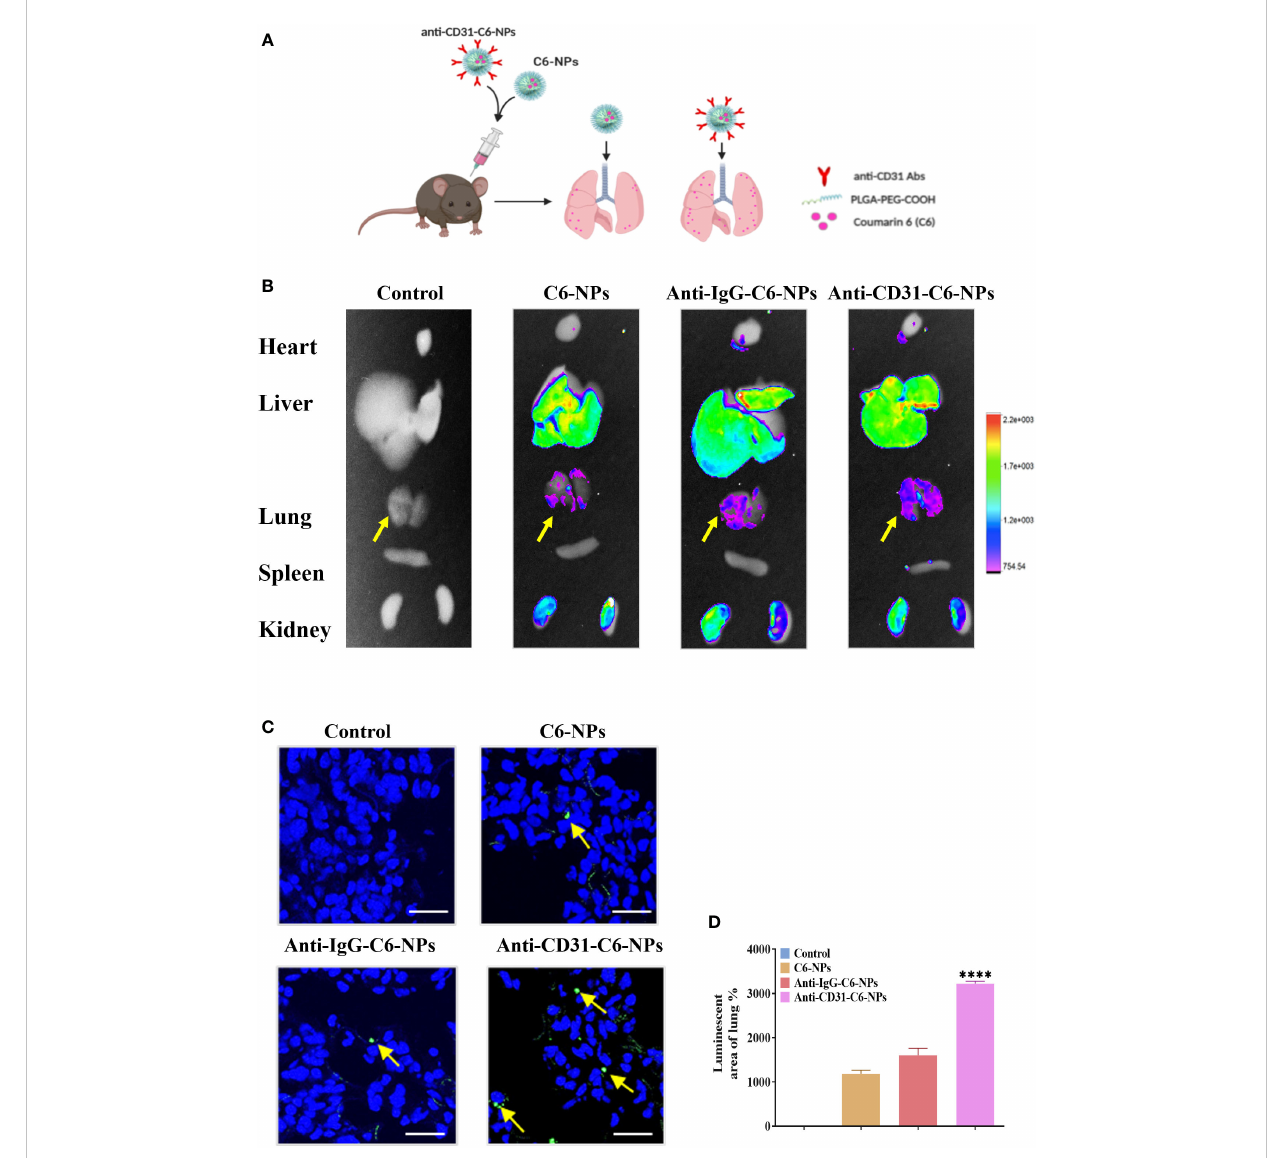
FIGURE 5 Anti-CD31-ORI-NPs selectively accumulated in the lung tissues. (A) C57BL/6 mice (n=3) were intravenously injected with 5 mg kg -1 NPs (Control), C6-NPs, anti-IgG-C6-NPs or anti-CD31-C6-NPs, respectively. The mice organs were collected for fl uorescence examination by IVIS after 6 hours. (B) The NPs biodistribution was analyzed by in vivo imaging system to calculate the fl uorescence intensity. (C, D) The fl uorescence intensity of lung tissue sections was examined and quanti fi ed. Representative fl uorescence image of C6 (green) distribution in lung tissue. DAPI (blue) counterstains cell nucleus. Bars: 50 m m. Data were expressed as mean ± S.E.M. ****p< 0.0001, compared to the C6-NPs